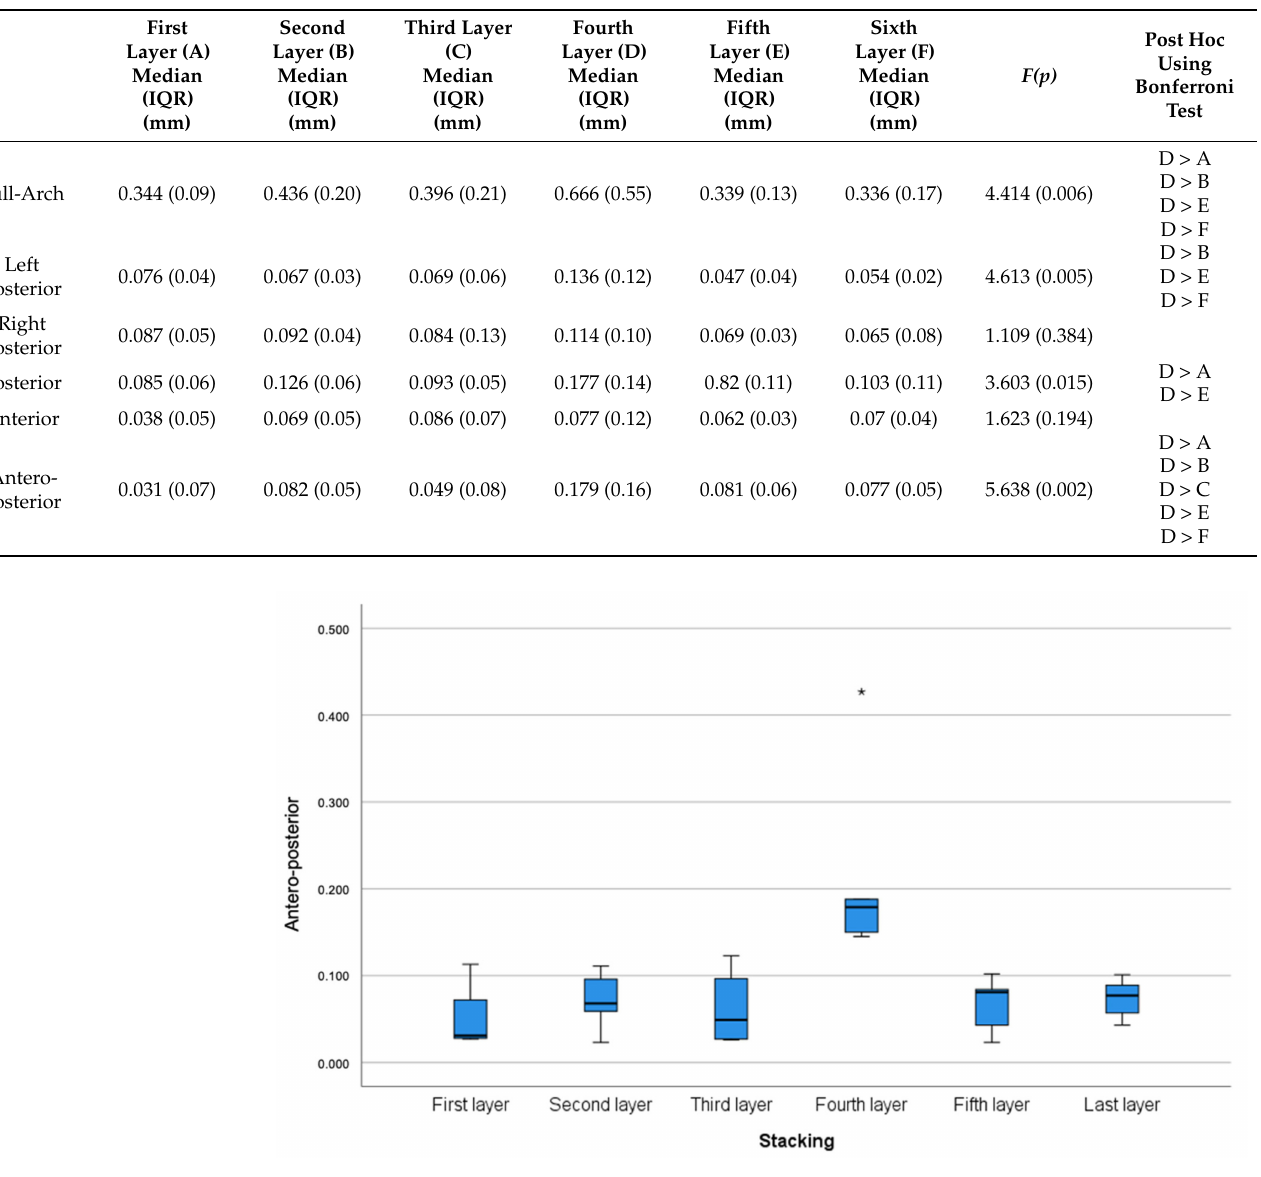
Figure 4. Anteroposterior segment arch error (trueness and precision) calculated through the vec- tors extended between the centres of the spheres (vectors V 3 , V 18 ) according to stacking layers. Measurements in millimetres. * Denotes outliers. Table 3. Median error (trueness) of left and right posterior arch segments and precision, expressed as interquartile error (IQR). Measurements in millimeters. Right